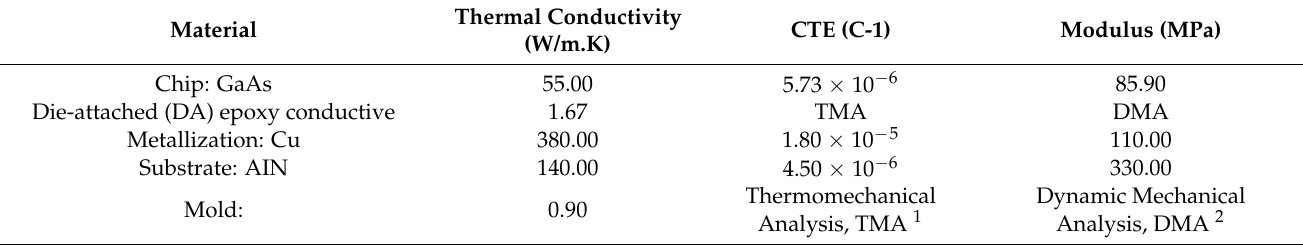
Table 1. Material selection for three types of VCSEL packaging was created based on features and characteristics parameters for thermal conductivity (W/m.k), CTE, and